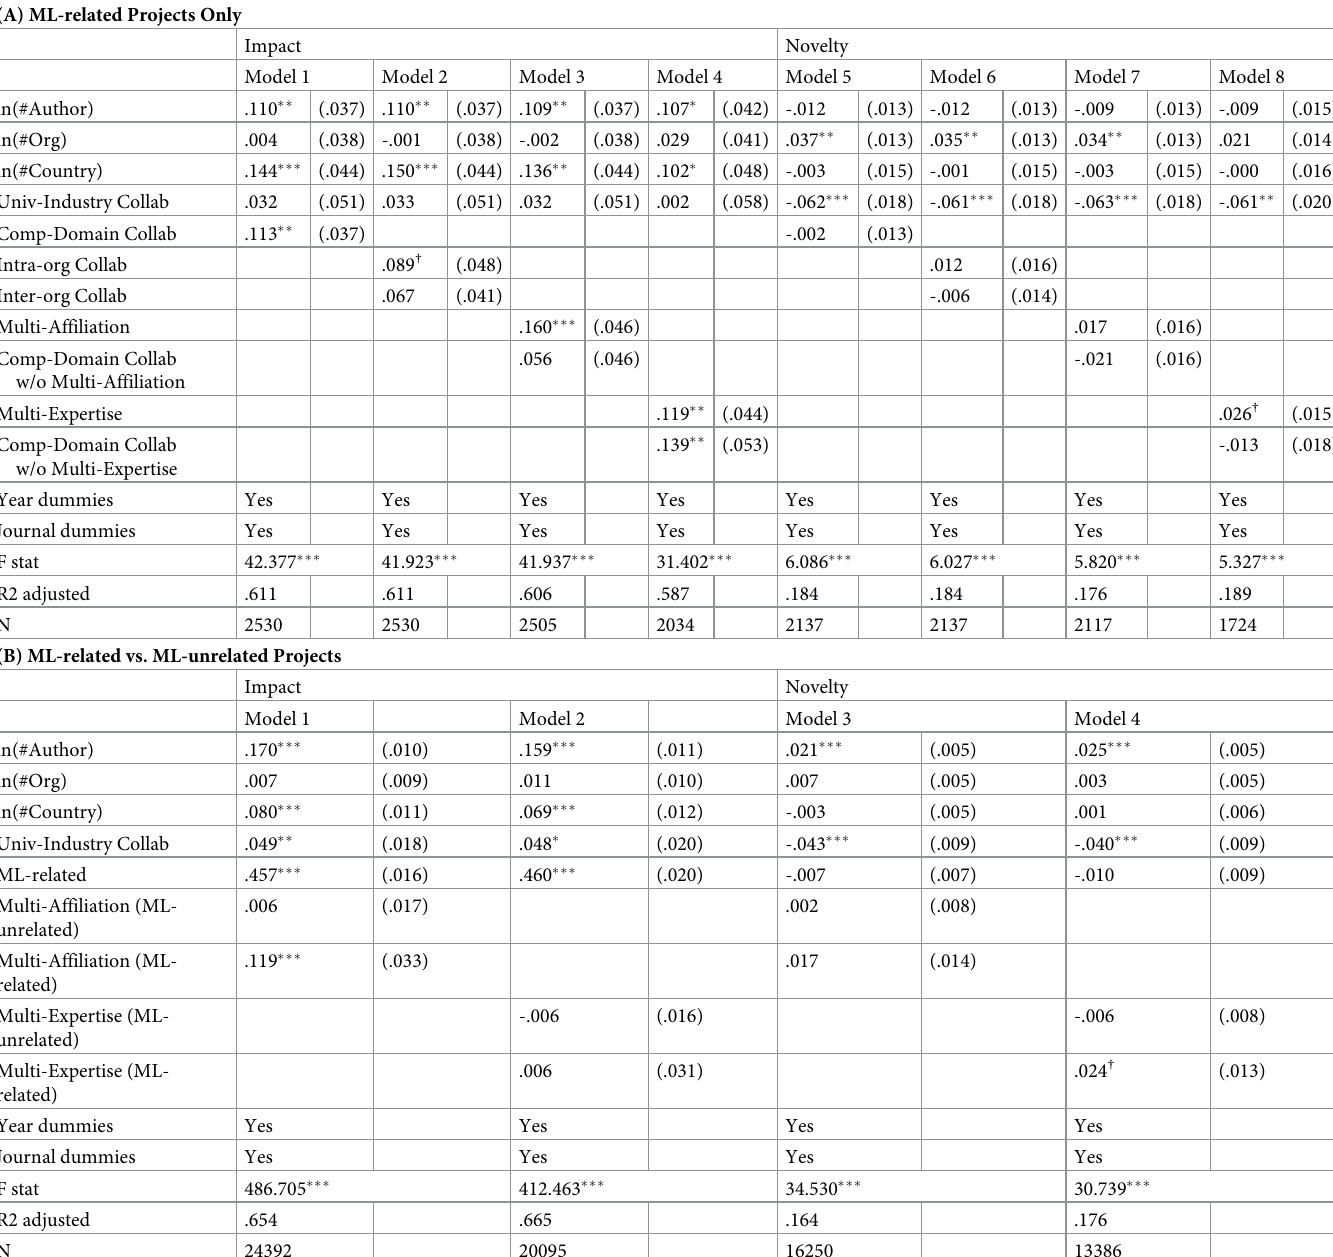
Table 3. Prediction of publication quality by team